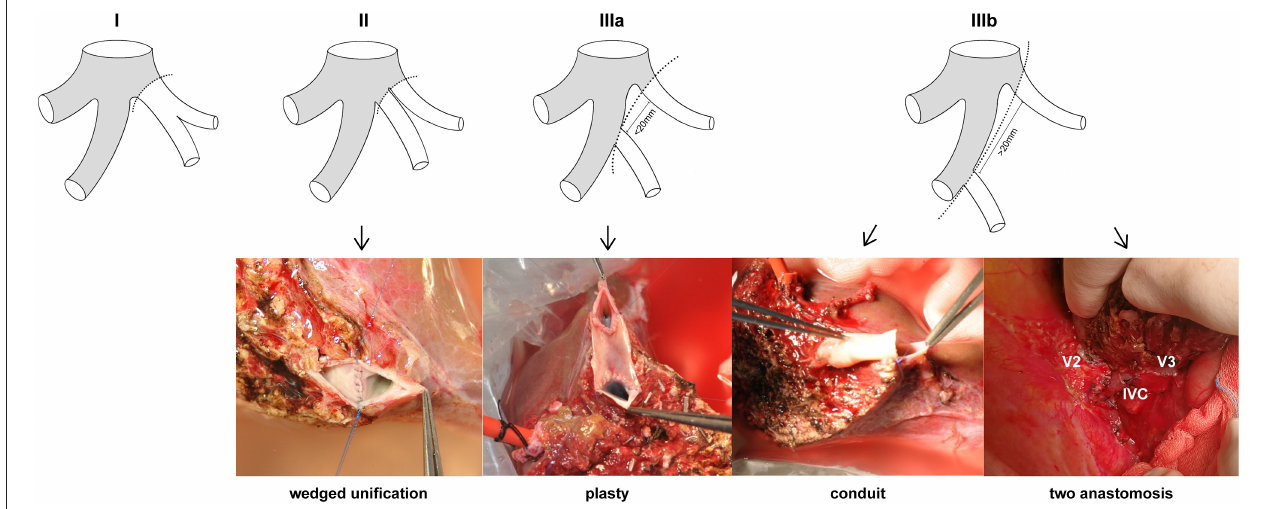
FIGURE 2 | Anatomical variations of LHV in LLS grafts. Type I: a single orifice; type II: two close orifices; type IIIa: two separated orifices (distance < 20mm); type IIIb: two separated orifices (distance > 20mm). Wedge unification is the first choice for type II. Venolasty to reform a common ostium is recommended for type IIIa. Conduit and two independent anastomosis are used for type IIIb.